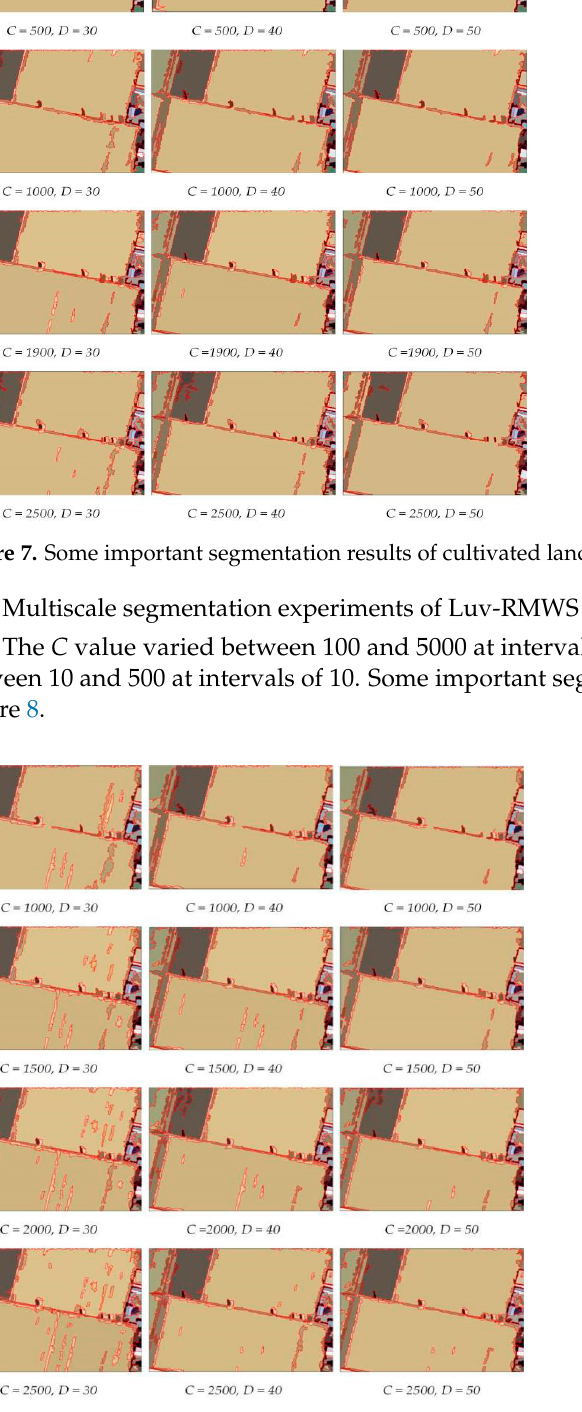
Figure 6. Some important segmentation results of cultivated land boundaries using the RGB- RMWS.